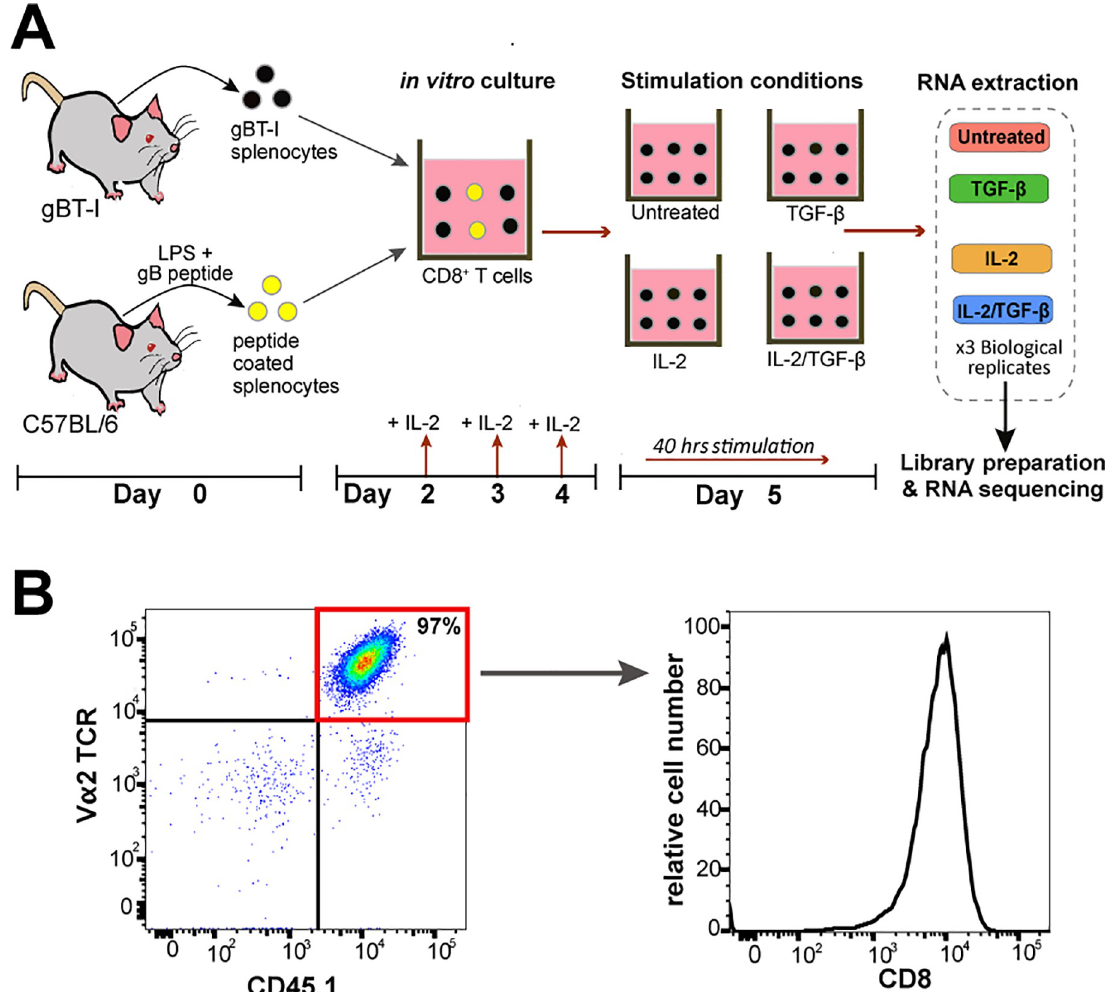
Fig 1. Schematic overview of the experimental design. (A) On day 0, wild type C57BL/6 splenocytes were coated with gB peptide and cocultured with gBT-I splenocytes in order to specifically activate gB-specific CD8 + T cells. Addition of IL-2 on days 2, 3, and 4 maintains T cell proliferation. At day 5, a highly pure population of activated CD8 + gBT-I T cells was subjected to four conditions: unstimulated control, TGF- β , IL-2, and TGF- β /IL-2. After 40h of TGF- β stimulation, cells were subjected to RNA extraction and RNA sequencing; N = 3 independent experiments. (B) Flow cytometric analysis of activated gBT-I cells on day 4. After pre-gating on live singlets, gBT-I cells are distinguished as CD45.1 + , v α 2 T cell receptor-positive (TCR + ), and CD8 + cells. The representative dot plot (left) of CD45.1 and v α 2 TCR staining, indicates the enrichment of gBT-I cells (red quadrant). The representative histogram (right) shows the expression of CD8 on gBT-I cells. The dot plot and histogram are representative of over 3 independent experiments.